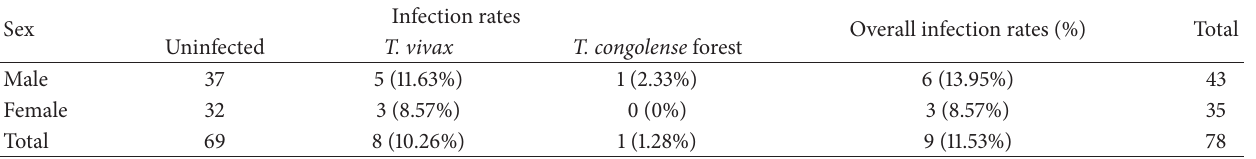
Table 4: Comparison of infection rates in male and female